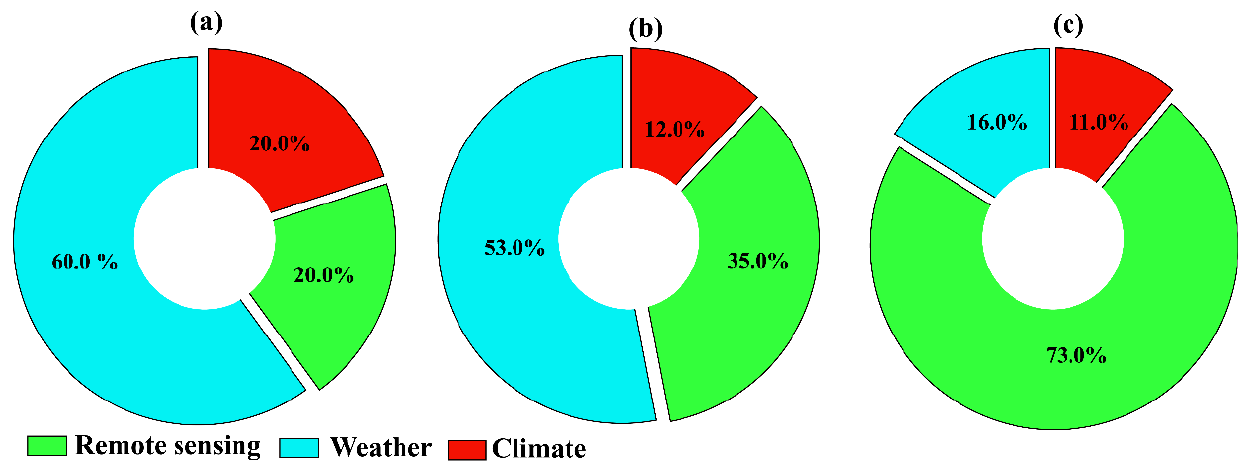
Figure 4. Importance of the different inputs datasets for yield prediction from January ( a ); February ( b ) and March ( c ). The considered predictors variables and their time span of the year for each model are reported in Table 2.